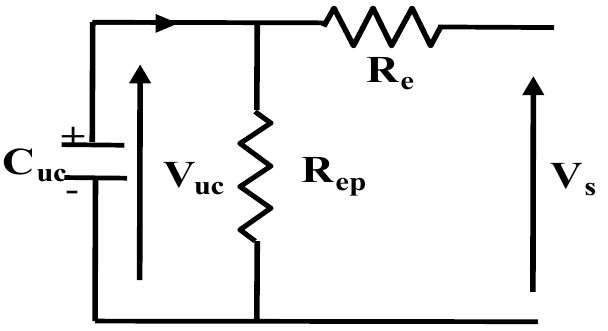
Figure 5. Electric model of ultracapacitor.